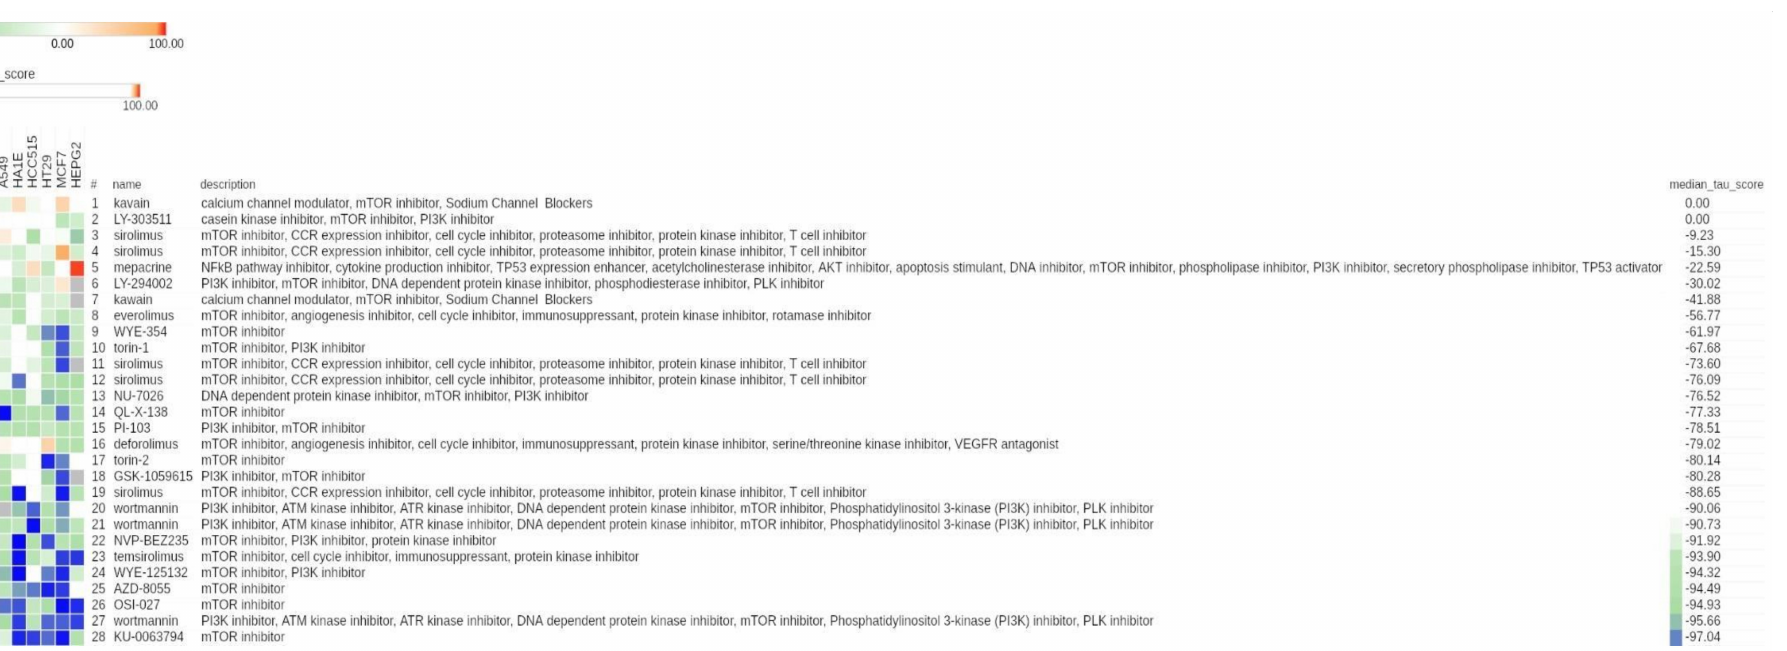
Figure 2. CMap results related to mTOR inhibitors in the entire CMap reference database. Heat map showing the connectivity score between each cell line (columns) and compound (rows). The heat map was generated using the CMap tool. The compounds are relative to the entire class of mTOR inhibitors. The unique numeric identifier, compound name, description, and median tau score of each compound are indicated. The cell line identifier is shown on the top of the map. The median tau score measures the strength of connection between a query signature and a drug across multiple cell types. Compounds are sorted by decreasing order of median tau score. Color keys are displayed on top of the